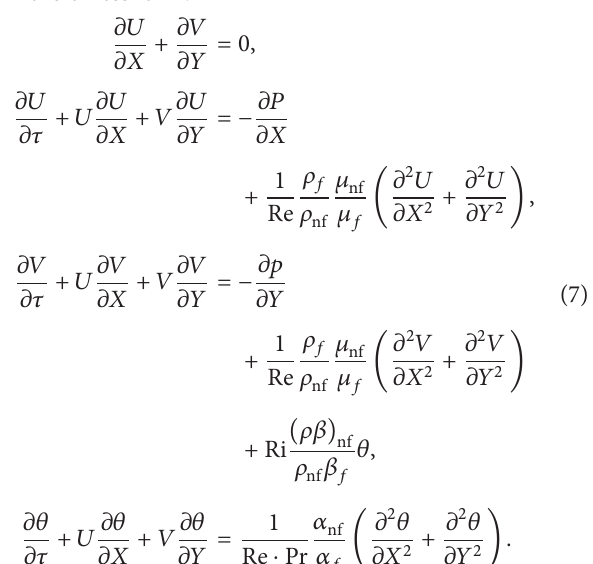
for the cavity filled with tot